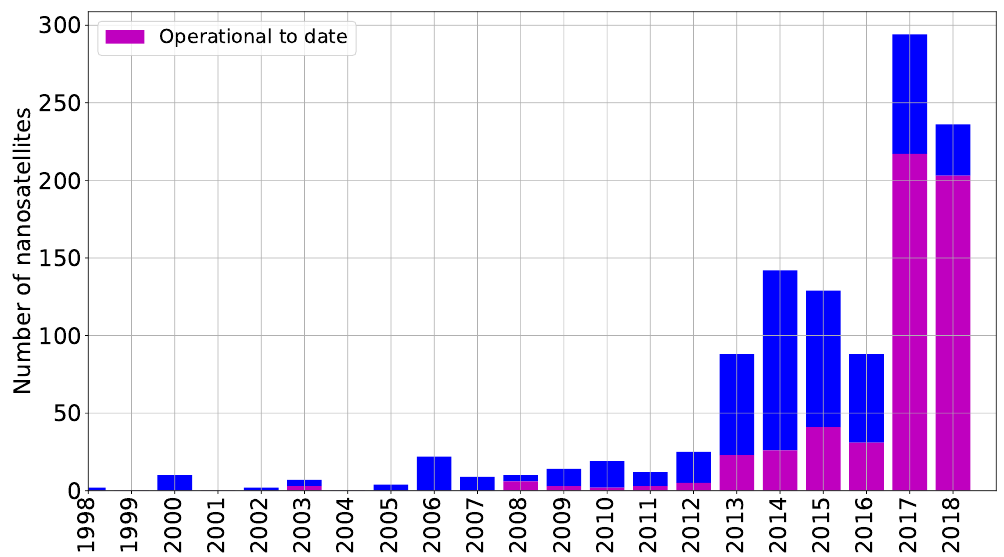
Figure 3. CubeSats launched since 1998. Data taken from the database at